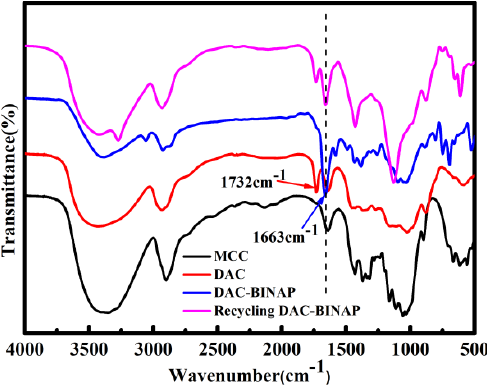
Figure 1. FT-IR spectra of MCC, DAC, DAC-BINAP and Recycling DAC-BINAP.